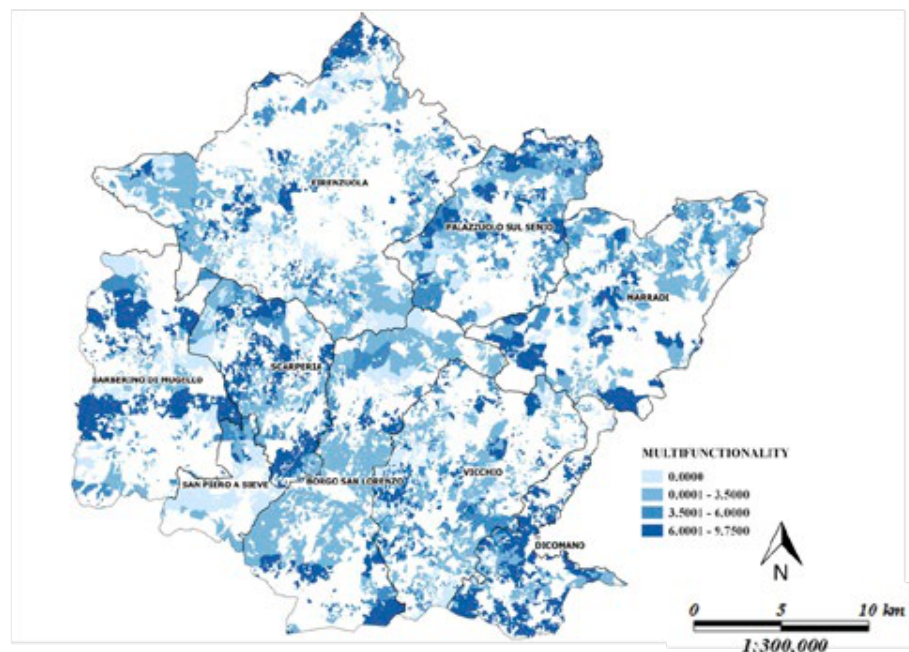
Figure 7. Map of multifunctional diversification in